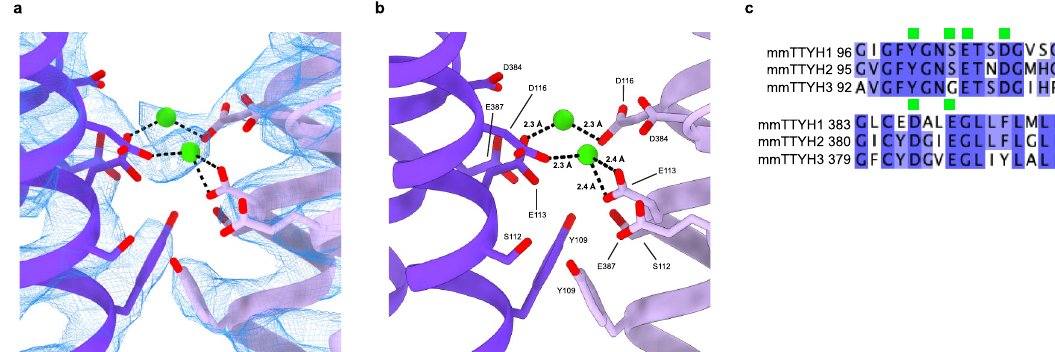
mesh). Electronegative side chains from each protomer are displayed as sticks and Ca 2 + ions are shown as green spheres. c Alignment of mouse TTYHs with electronegative residues near the Ca 2 + binding sites indicated with green boxes and conservation colored from white (not conserved) to blue (most conserved).